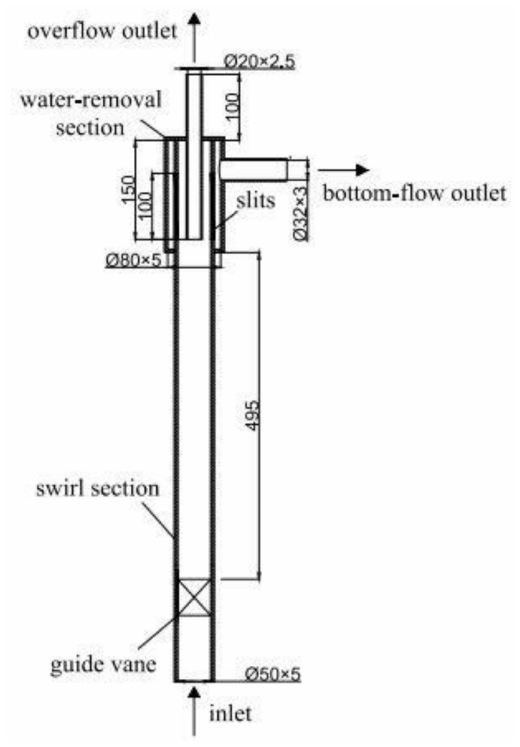
Figure 1. Structure of the axial hydrocyclone separator (unit: